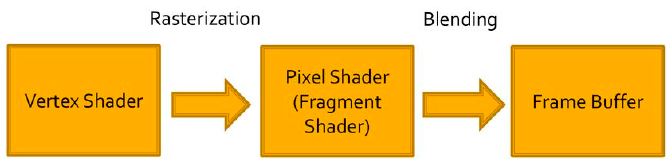
Figure 2. Sequence of transformations made in a Graphic Processing Unit (GPU) to generate the final 2D images for each display.